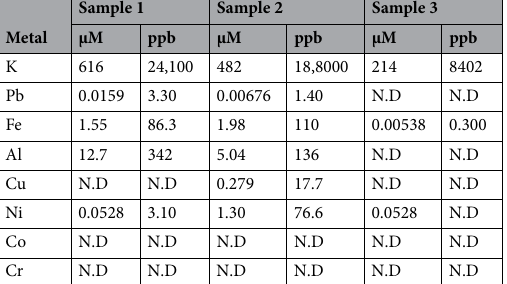
Table 4. Metal concentrations determined by ICP-OES analysis in the wastewater